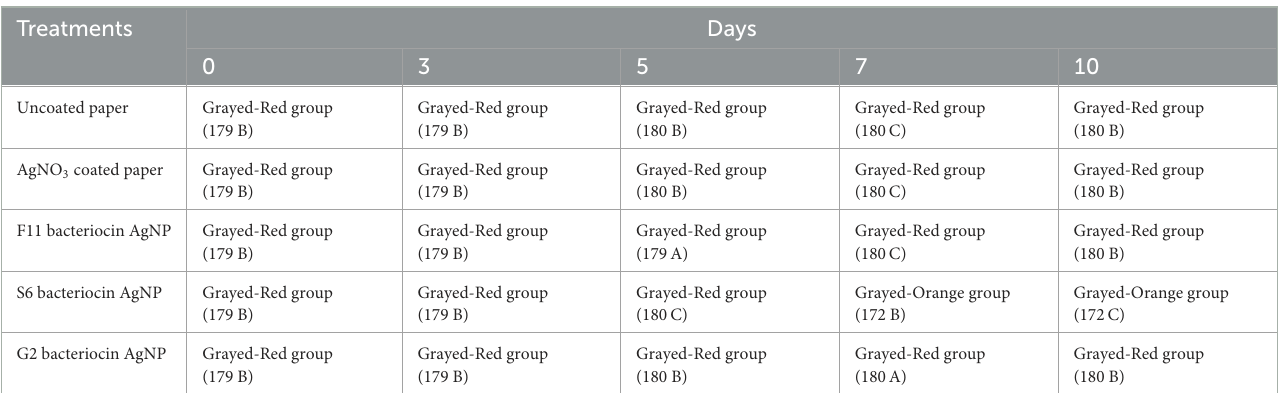
TABLE 4 Effect of packaging on color of Tomato ( Solanum lycopersicum ) during storage.